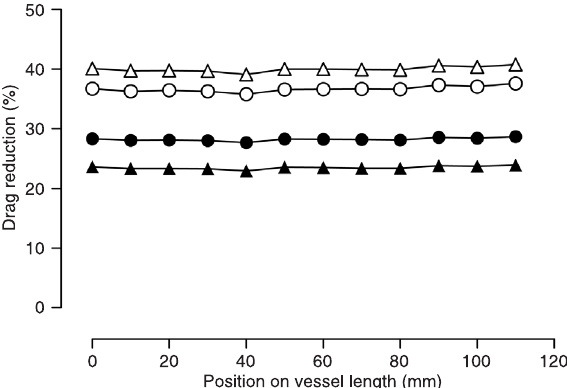
Figure 6. Percent drag reduction by PEG 4000 (derived from the computer simulated graphs in Figure 5) along the vessel length in Wistar rats (circles) and spontaneously hypertensive rats (SHR, triangles), before (open symbols) and after endothelium damage (filled symbols). Drag reduction values along the vessel length were higher in the presence of endothelium than after damage, and in the tail arterial bed from SHR compared to Wistar